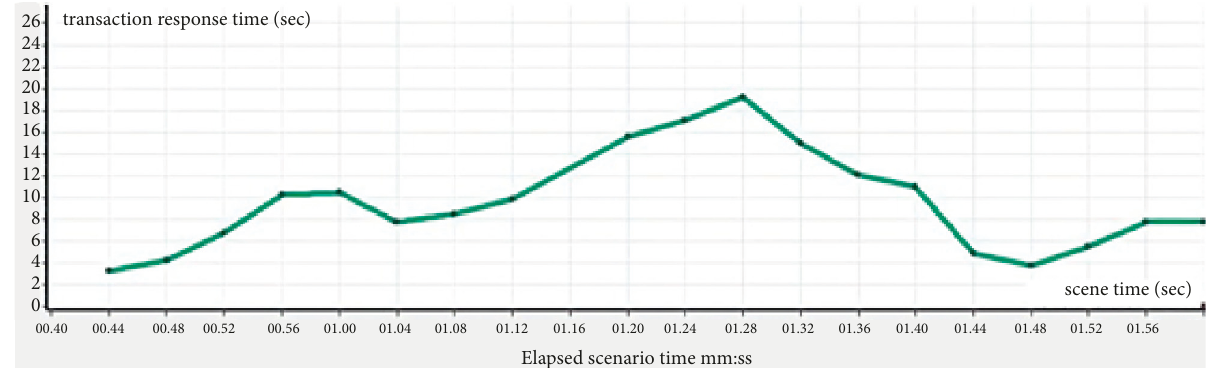
Figure 10: Response time of expansion deployment in virtual machine